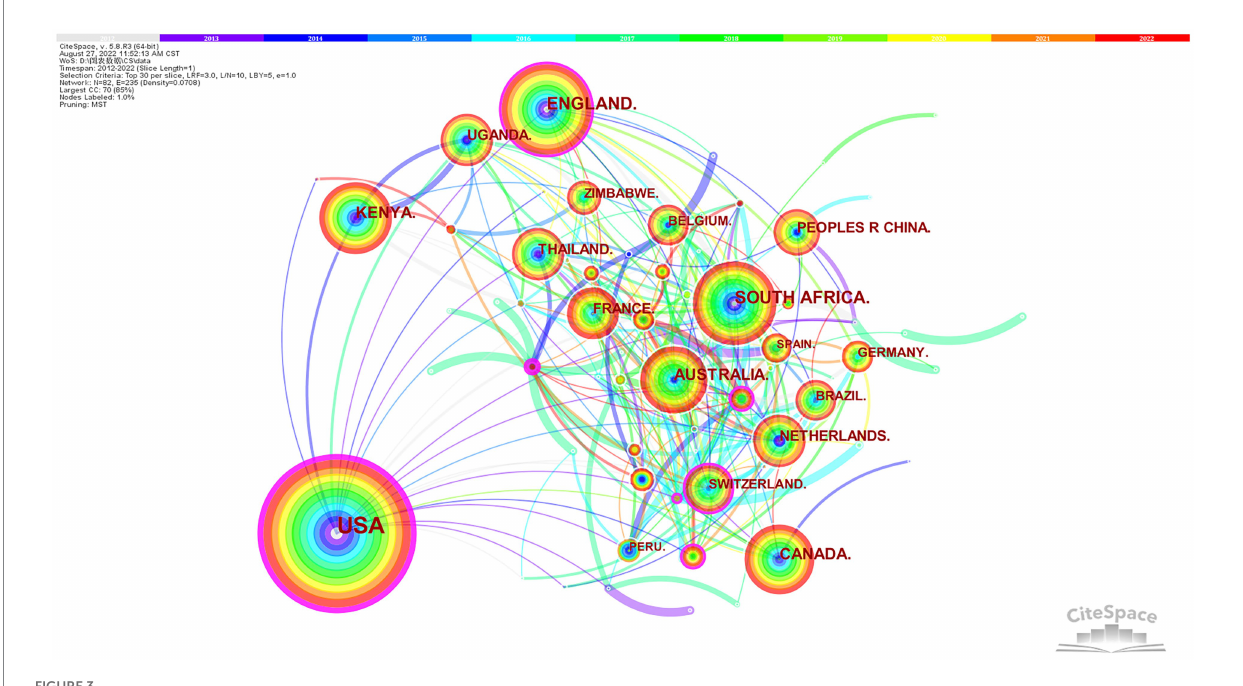
FIGURE 3 The network of countries.